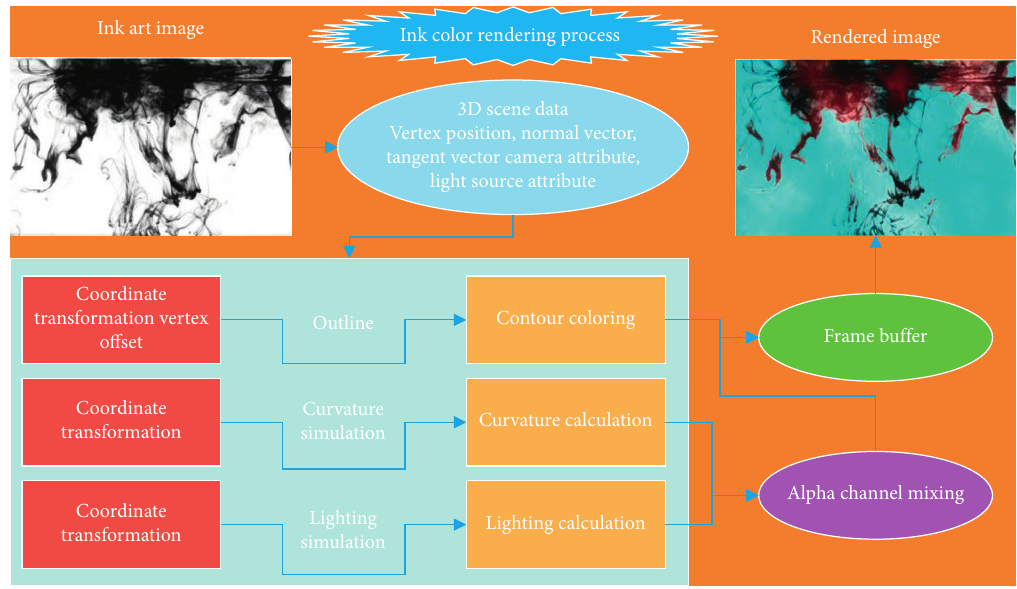
Figure 1: Ink color rendering